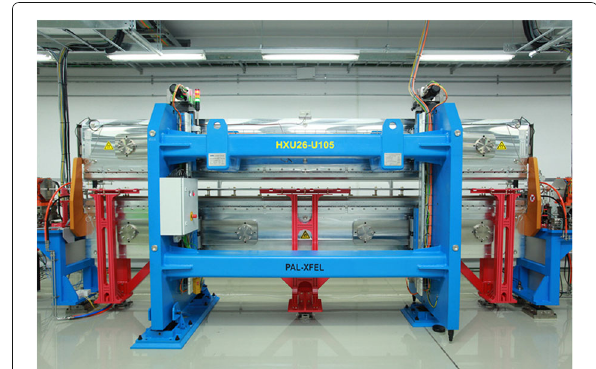
Fig. 7 The undulator for PAL-XFEL